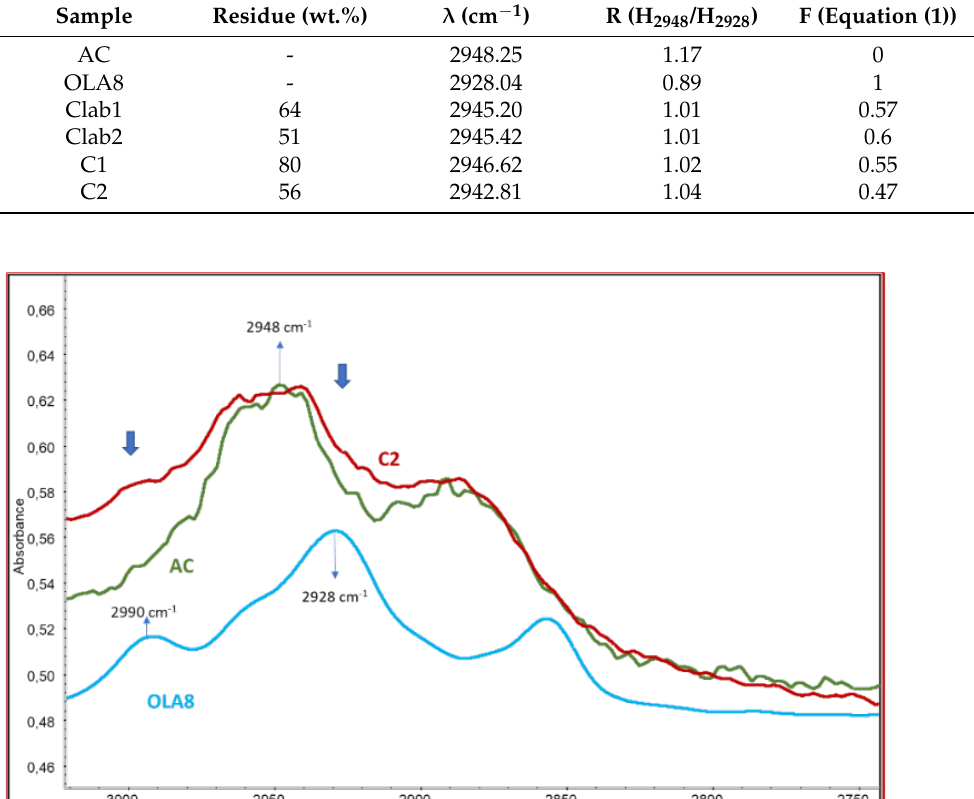
where, R is the height of the registered absorbance peak in the 2948–2928 cm − 1 range for the two compatibilizers, R OLA8 is the height of the registered absorbance peak at 2928 cm − 1 and R AC is the height of the registered absorbance peak at 2948 cm − 1 . Since F = 0 for pure AC, and F = 1 for pure OLA8, expected F values are in the 0–1 range for compatibilizers when the coupling reaction has occurred. Results are reported in Table